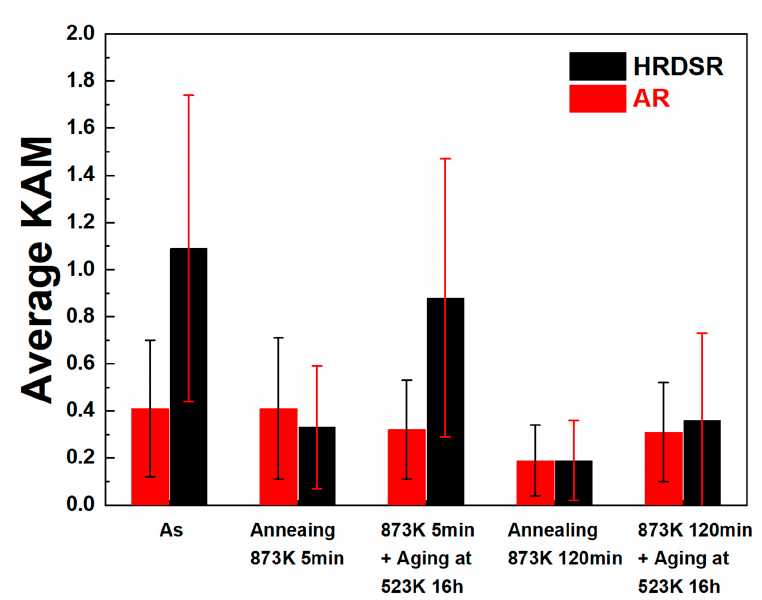
Figure 8. The average KAM values of the AR and HRDSR samples after annealing or annealing plus aging.